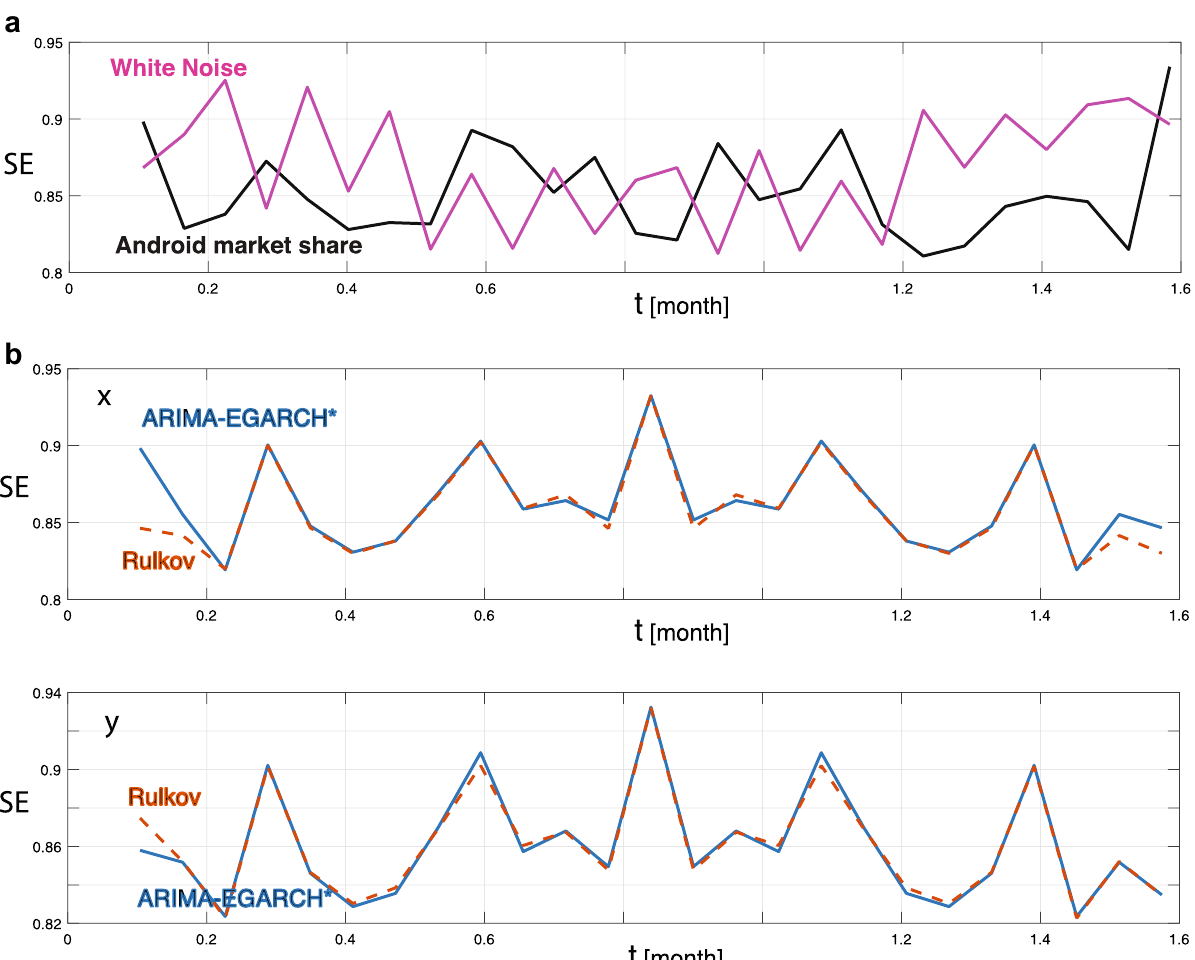
Figure 7. Spectral entropy SE ( a ) of the log-changes of Android’s market share (black) versus that of a white noise signal (magenta) exhibiting similar entropy levels; ( b ) of the stochastic (blue, continuous line) vs. the deterministic (orange, dashed line) calibrated approaches, for x - (top) and for y -variable (bottom). The almost perfect overlap of the two aligns well with the real-world data shown in ( a